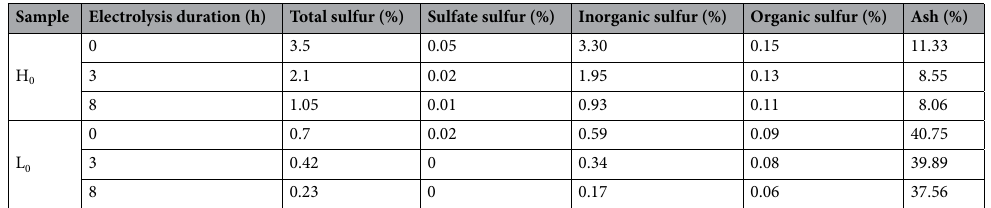
Table 2. Sulfur removal rate in coal after 3 h and 8 h